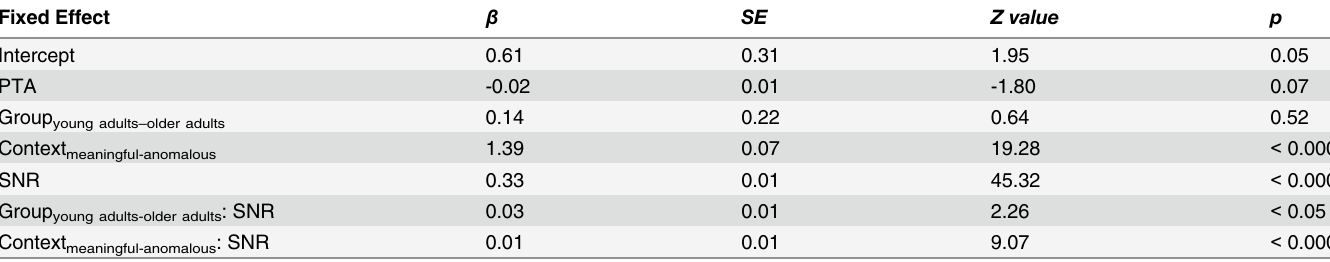
Table 3. Log odds of producing a correct response across group, context, and SNR in the audio-only